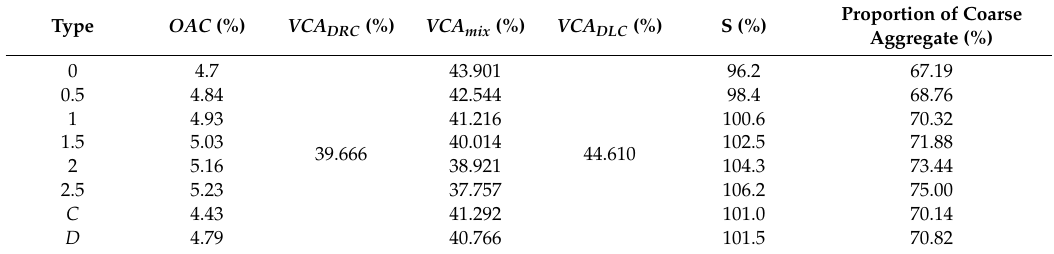
Table 14. Parameters of structural determination under optimum asphalt–aggregate